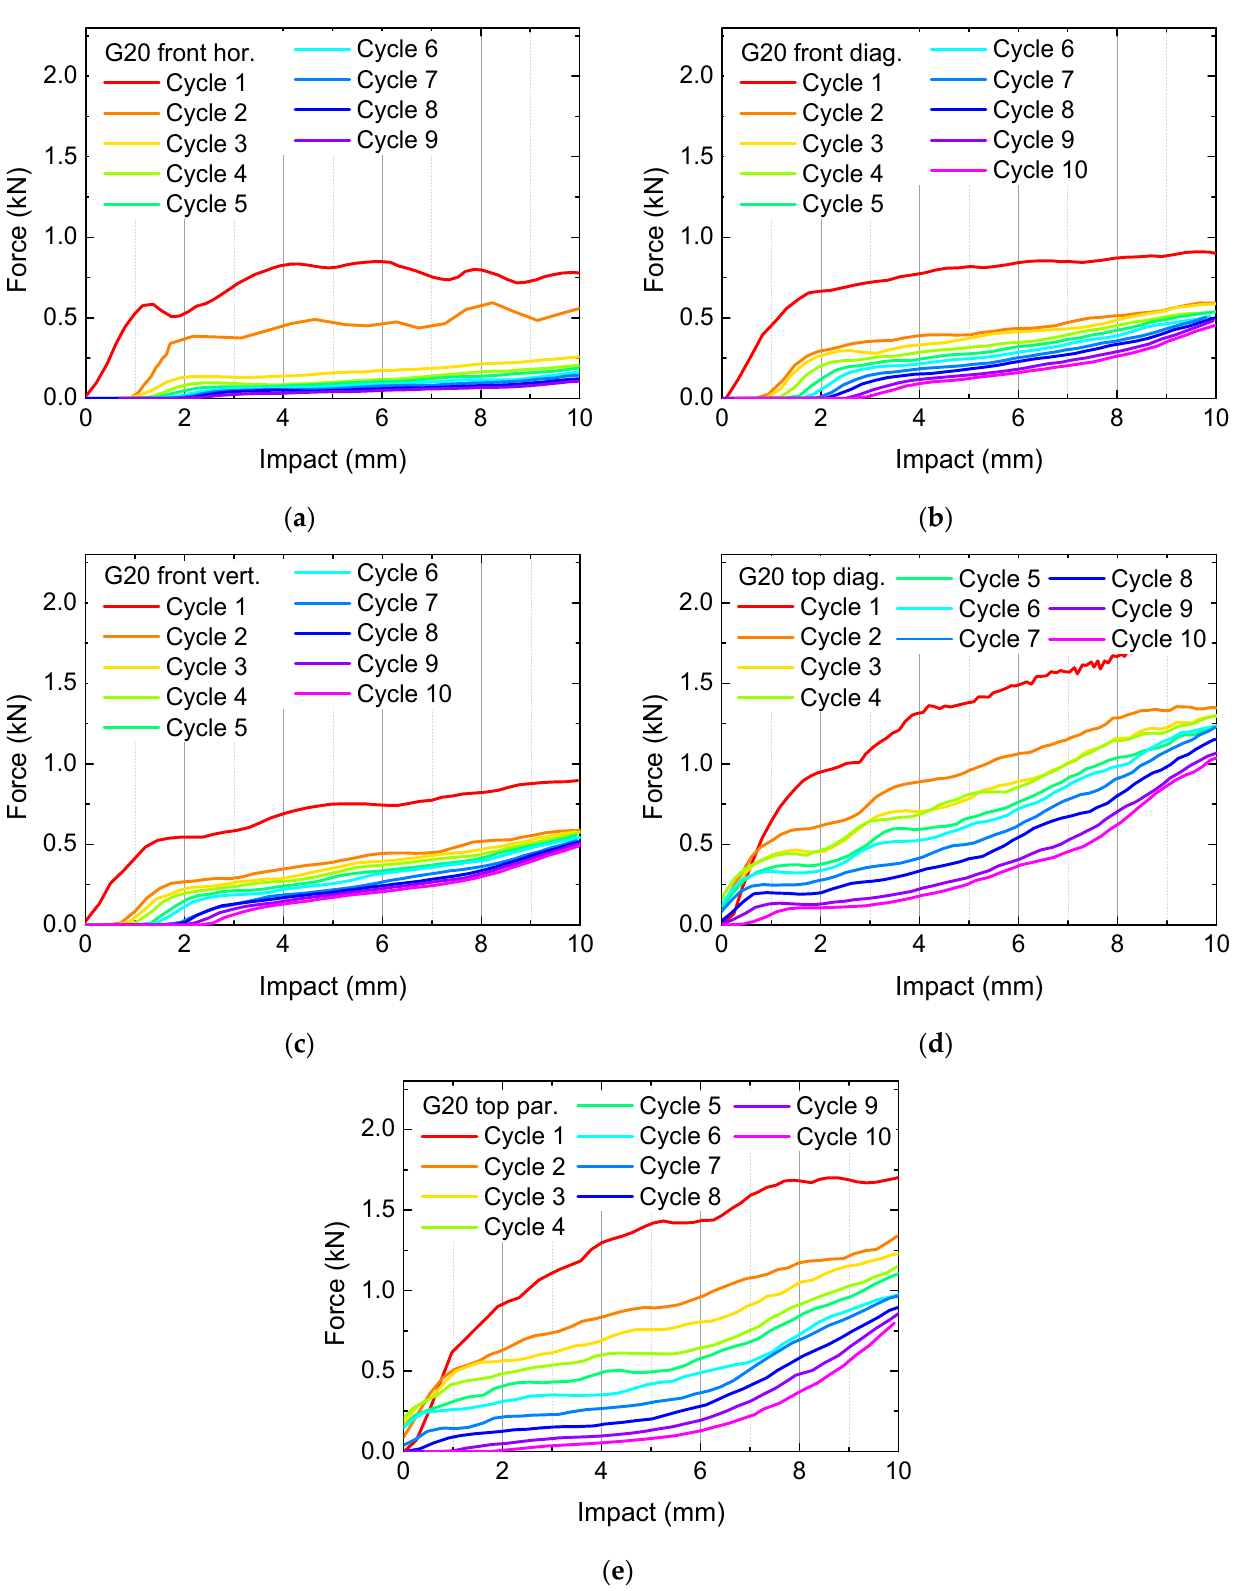
Figure 3. Quasi-static load tests in original state and after several test and recovery processes of samples G20: ( a ) front horizontal; ( b ) front diagonal; ( c ) front vertical; ( d ) top diagonal; ( e ) top parallel to the edges. The y-axes are scaled differently from Figure 2.